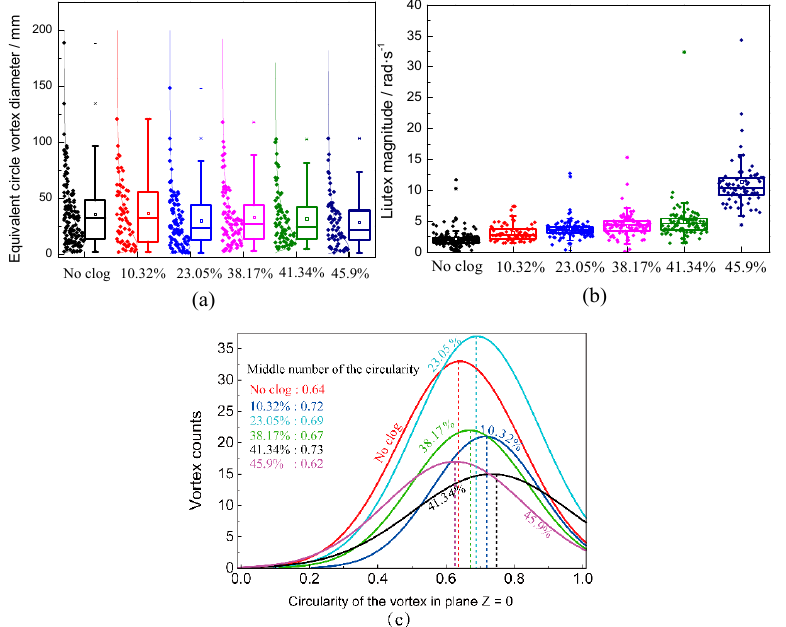
Figure 9. The statistic distribution of ( a ) the vortex diameter, ( b ) the Liutex magnitude, ( c ) the distribution curve of the vortex circularity.